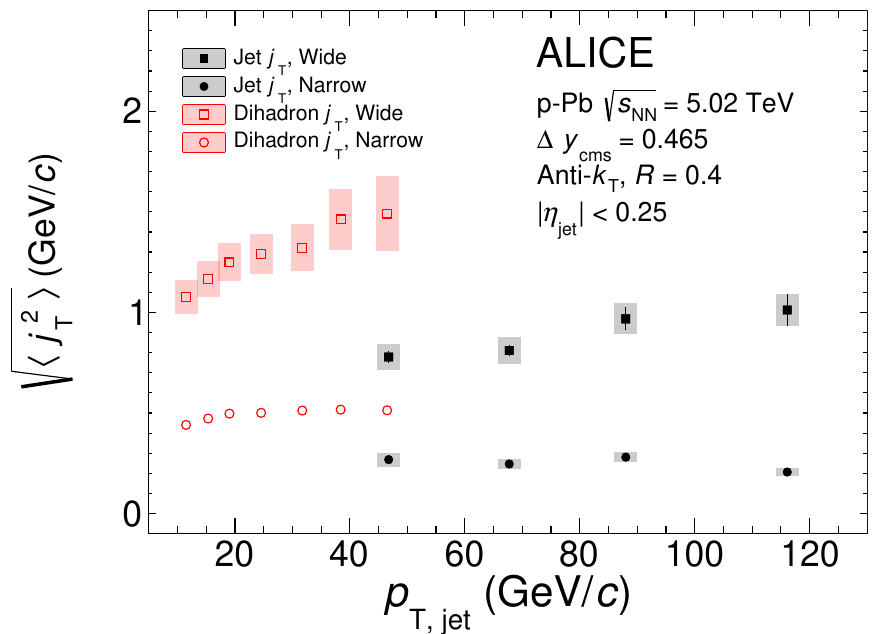
Figure 6. Comparison of results from the jet-based and dihadron-based j T analyses [48]. Ranges of dihadron trigger p T ( p T , trigger ) are converted to corresponding p T , jet ranges using observed mean p T , jet values in p T , trigger bins. Dihadron results are shown for 0 . 2 < x longitudinal component fraction of the associated track momentum with respect to the momentum of the trigger track. The difference of the two analyses originates from the different kinematic selections and the choice of the axis used for the j T calculation. See text for more